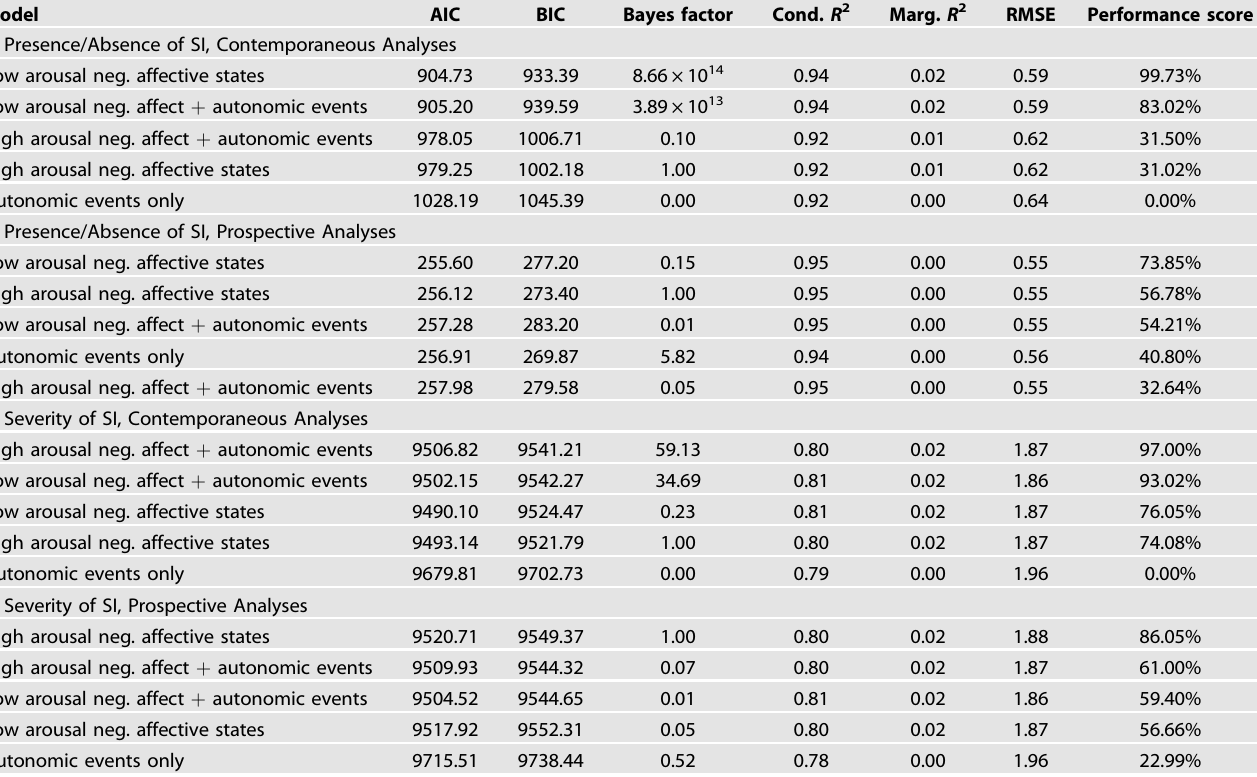
Table 2. Model information and model comparison statistics for hourly-level data, ordered by